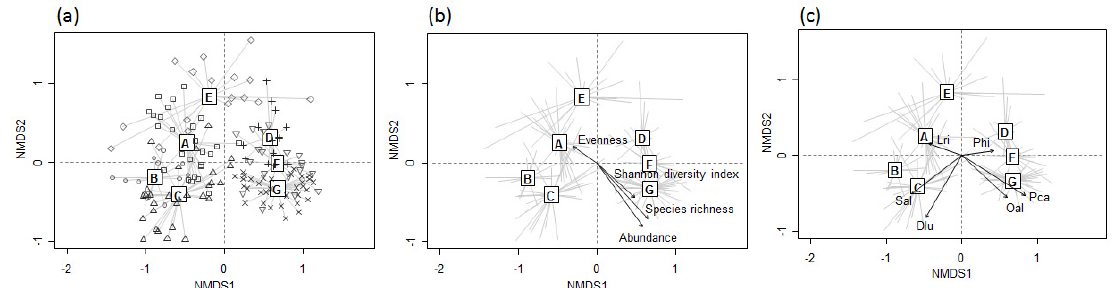
Figure 5. ( a ) The NMDS ordination of odonate assemblages based on the weight vectors of SOM units (stress value: 0.203); ( b ) biplots with community indices; and ( c ) the most significant indicator species in each cluster. Abbreviations for indicator species are given in Table 2.